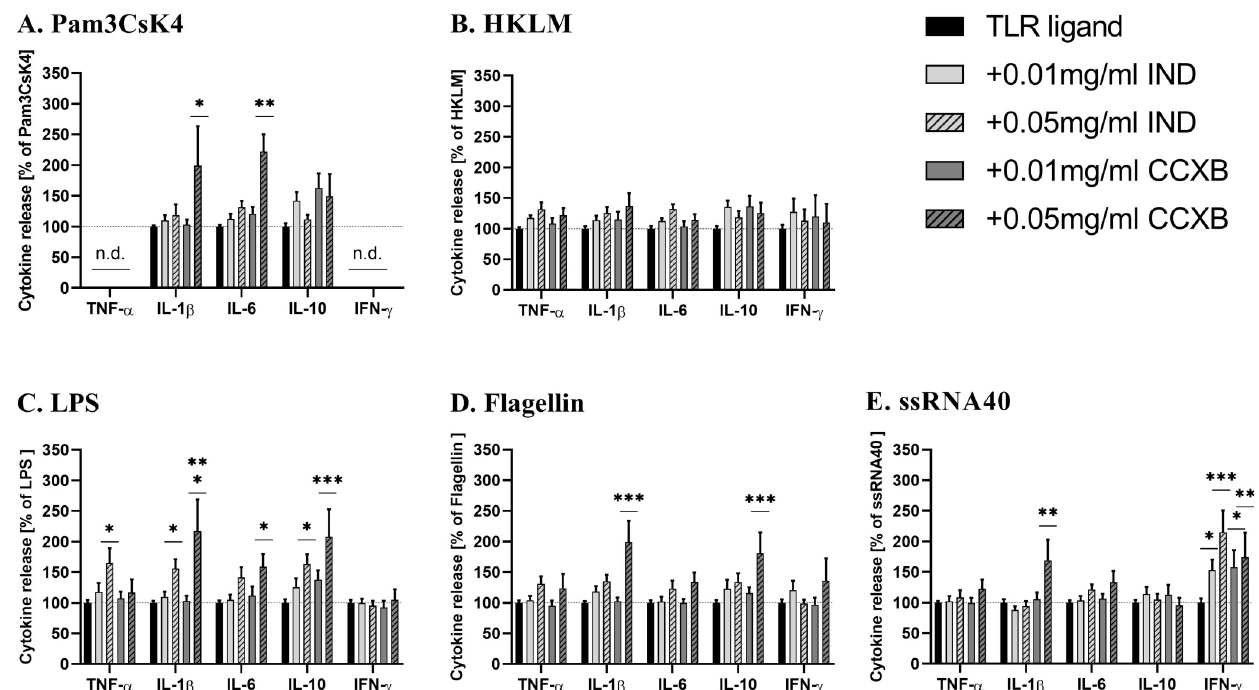
Fig 4. Minor cytokine modulating effects of Indomethacin (IND) in comparison with Celecoxib (CCXB) in TLR ligand-stimulated WB. Citrate- anticoagulated blood was incubated with 0.01 and 0.05 mg/ml Indomethacin, Celecoxib or vehicle 6h before stimulation with (A) Pam3CsK4 (B) HKLM (C) LPS (D) Flagellin and (E) ssRNA40. The cytokine production by cells stimulated without Indomethacin or Celecoxib (vehicle) was set as 100%. Data represent mean ± SD of six experiments performed in duplicate. Differences were significant at a p < 0.05 ( � ), p < 0.01 ( �� ) or p < 0.001 ( ��� ) as indicated, compared to WB incubated without ASA. n.d.—not